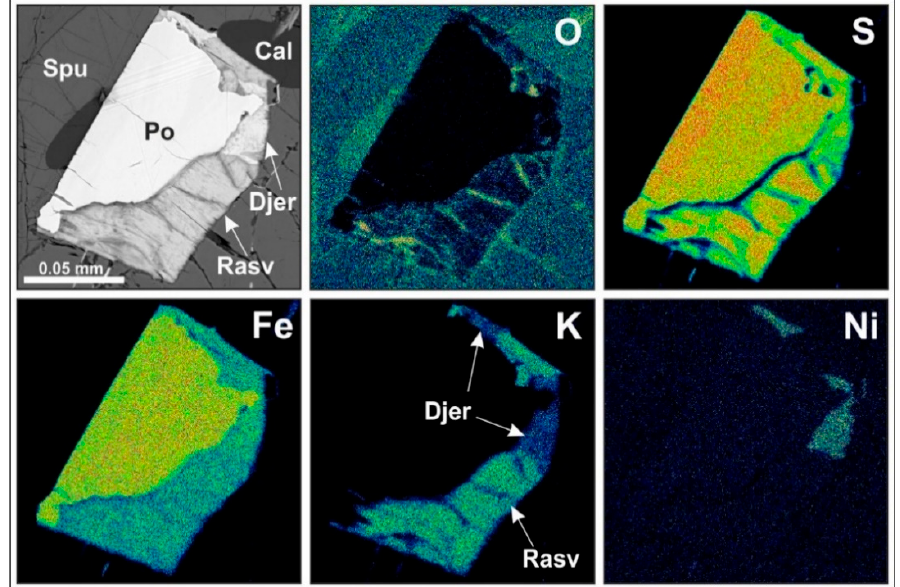
Figure 16. BSE image and X-ray elemental maps (O, S, Fe, K, Ni) of pyrrhotite partially replaced by rasvumite and djerfisherite. Elemental mapping revealed the constant presence of oxygen (O) in rasvumite, which indicates its partial oxidation. Kochumdek marble, Zone 2, sample PT-107. Cal = calcite, Djer = djerfisherite, Po = pyrrhotite, Rasv = rasvumite, Spu = spurrite. Table 10. Representative analyses of djerfisherite (K 6 (Fe,Ni,Co,Cu) 25 S 26 Cl) from marbles of the Kochumdek contact aureole Djerfisherite has a highly variable composition, with relatively constant K (8.93–9.90 wt%), (EPMA data). Fe in a range of 42.85 to 53.51 wt%, 1.08 to 1.57 wt% Cl, 32.75 to 34.89 wt% S, and Na content below the detection limits of both SEM-EDS and EPMA techniques (Table 10). The ranges